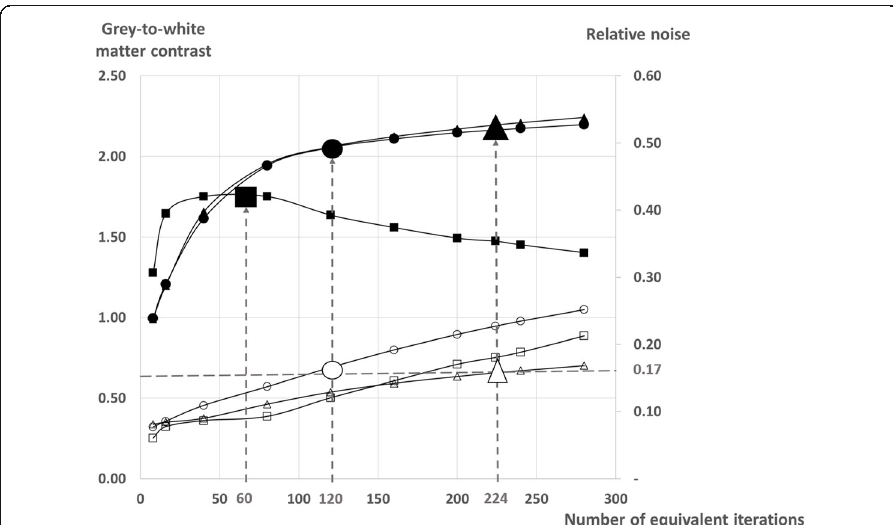
Fig. 1 Evolution, according to the number of equivalent iterations of image reconstructions, of the grey-to- white matter contrast from occipital cortex (black symbols, corresponding scale on the left side) and of the relative noise index from semi-oval centers (white symbols, corresponding scale on the right side), on the SPECT images of the brain phantom recorded with the conventional Anger gamma camera (squares), as well as with full-time (triangles) and half-time (circles) recordings from the CZT camera. The number of equivalent iterations considered to reach a high enough convergence for contrast and with an acceptable noise level is indicated by vertical dashed lines. The level of relative noise reached by the CZT-camera at these optimal convergence levels (0.17 for both half-time and full-time recordings) is additionally indicated by a horizontal dashed